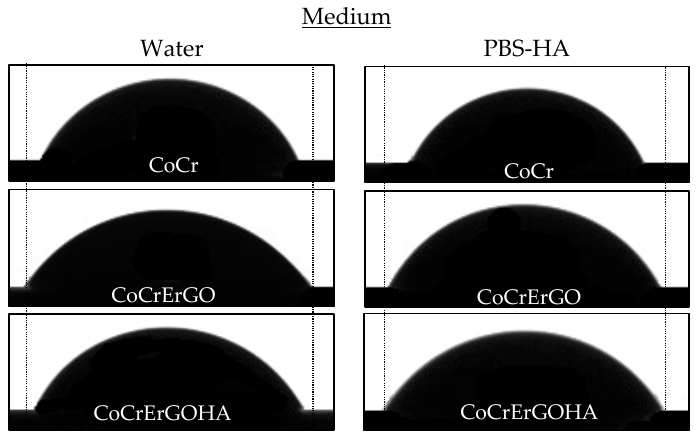
Figure 1. Contact angle images for CoCr, CoCrErGO, and CoCrErGOHA surfaces in water and PBS ‐ HA.